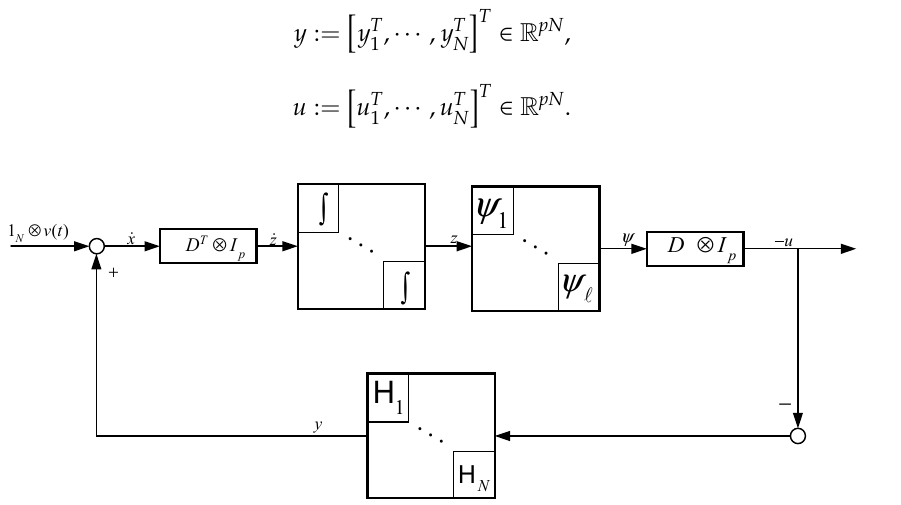
Figure 5. A feedback block diagram of the interconnected multirobot system with feedback.